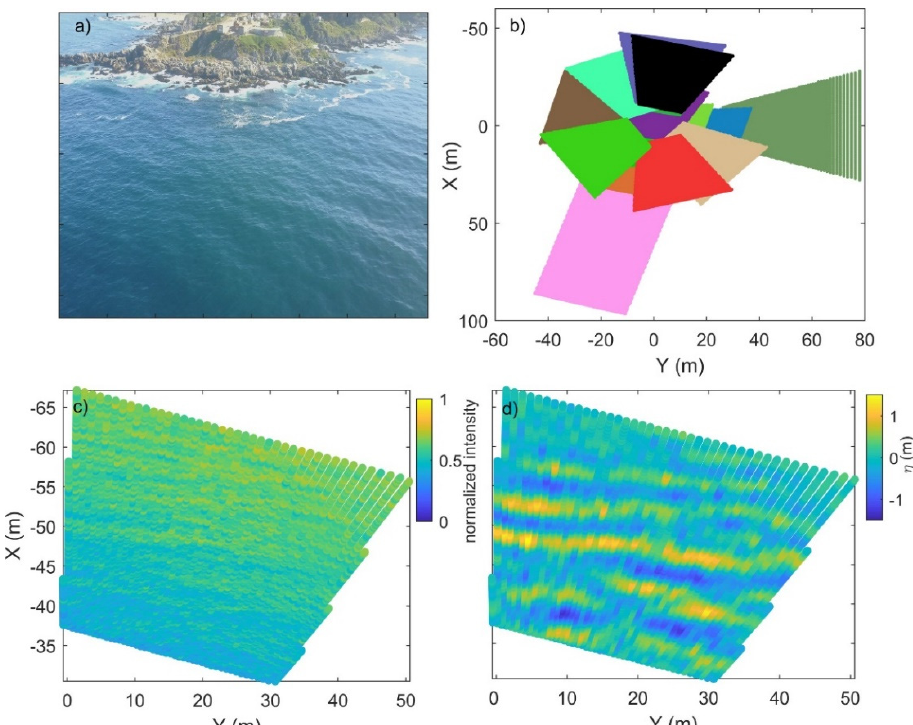
Figure 3. ( a ) A view of the study site for the drone (UAV) case, off the coast in deep water, Las Cruces, Chile. ( b ) View fields for the flights in Cartesian coordinates. ( c ) Raw normalized image intensity, and ( d ) the resulting free surface anomaly showing waves. ( c ) and ( d ) correspond to black flight in ( b ).